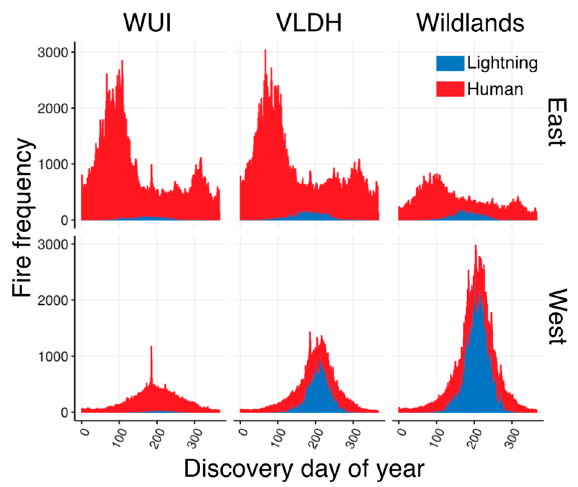
Figure 3. Frequency distributions of human- and lightning-caused wildfires by Julian discovery day of year stratified by wildfires that started either in the wildland-urban interface (WUI), Very low-density housing (VLDH), or wildlands within the eastern or western U.S. between 1992 and 2015.